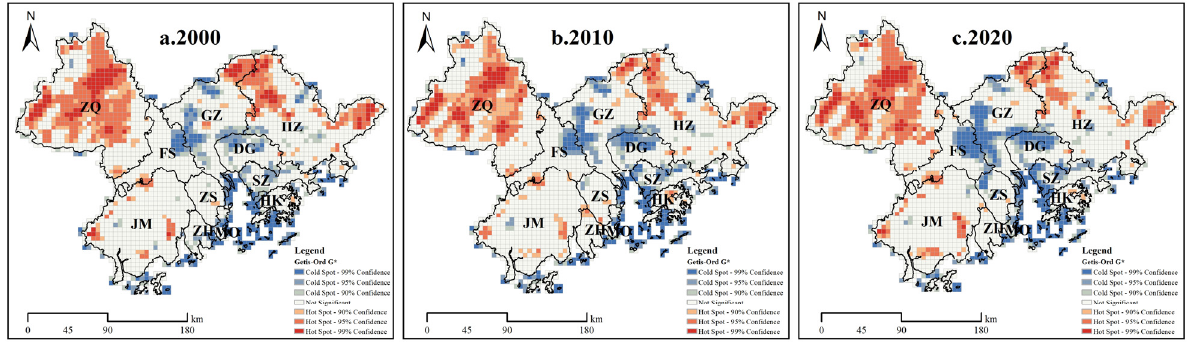
Figure 5. Spatial agglomeration characteristics of the EHI in the GBA, 2000–2020.